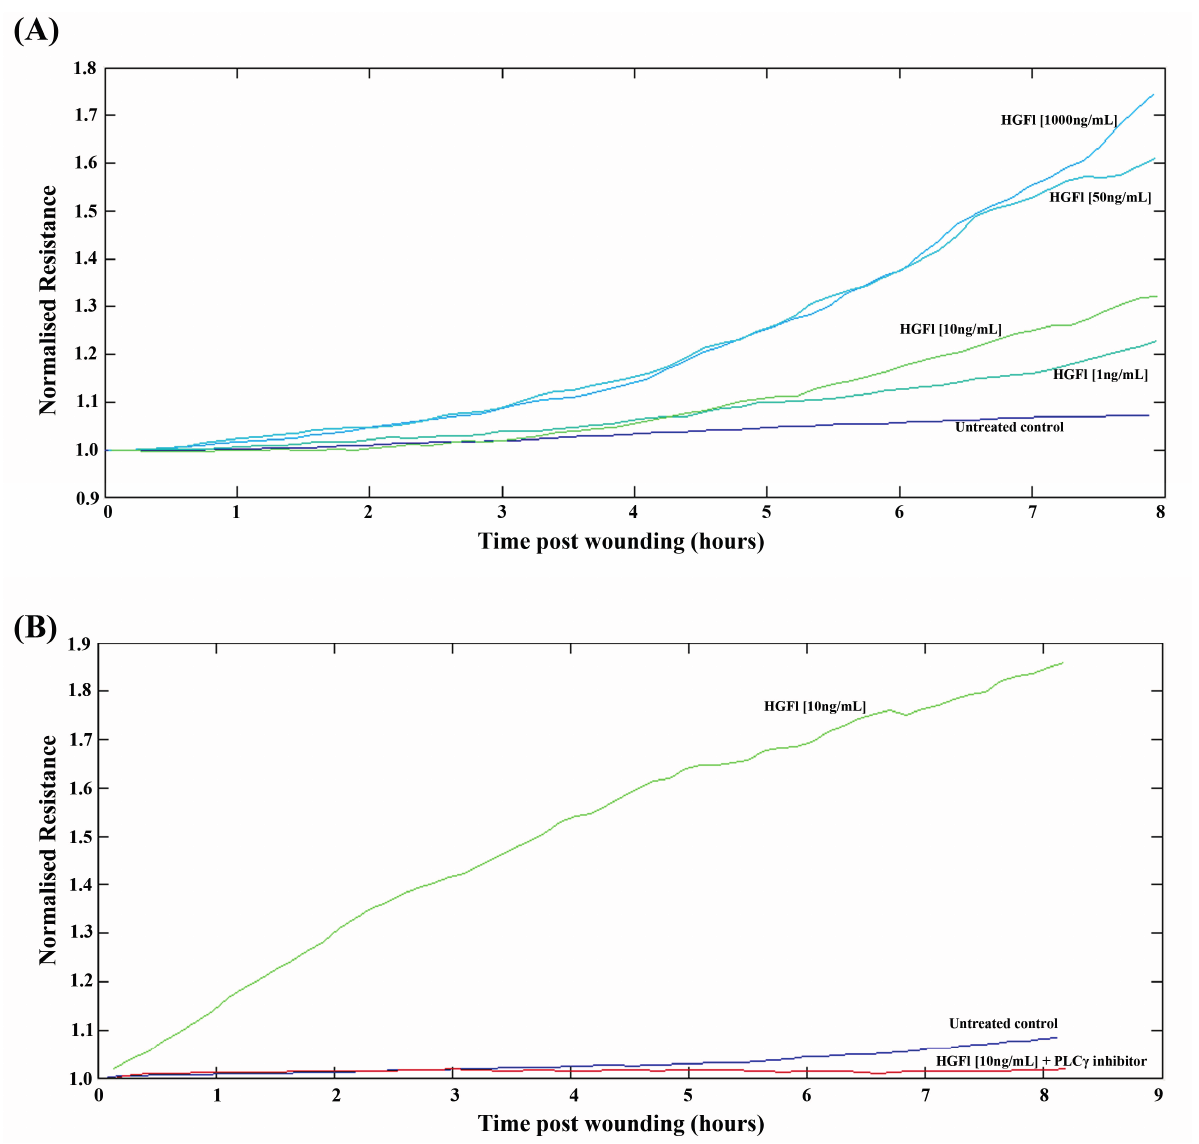
Figure 4. ECIS analysis of the impact of HGFl on HaCaT cell migration. rhHGFl enhanced HaCaT cell migration rates over all concentrations tested, with the strongest response being observed at 50 ng/mL and 1000 ng/mL concentrations ( A ) Inhibition of PLC γ signaling inhibited the pro-migratory response elicited by rhHGFl ( B ). Representative images